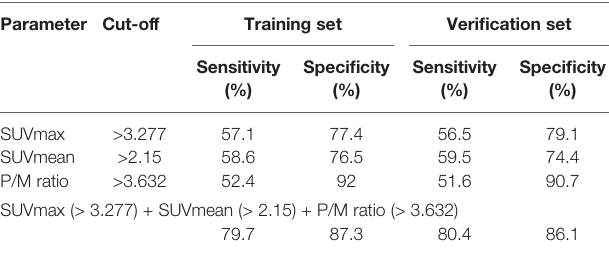
TABLE 2 | Diagnostic ability of single parameters and parameter combination.